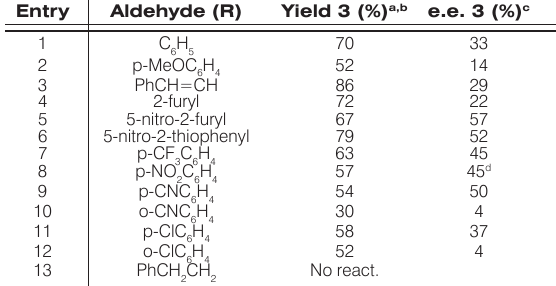
Table 4. Allylation of aldehydes in the presence of (R)-methyl p-tolyl sulfoxide 4a. Entry Aldehyde (R) Yield 3 (%) a,b e.e. 3 (%)